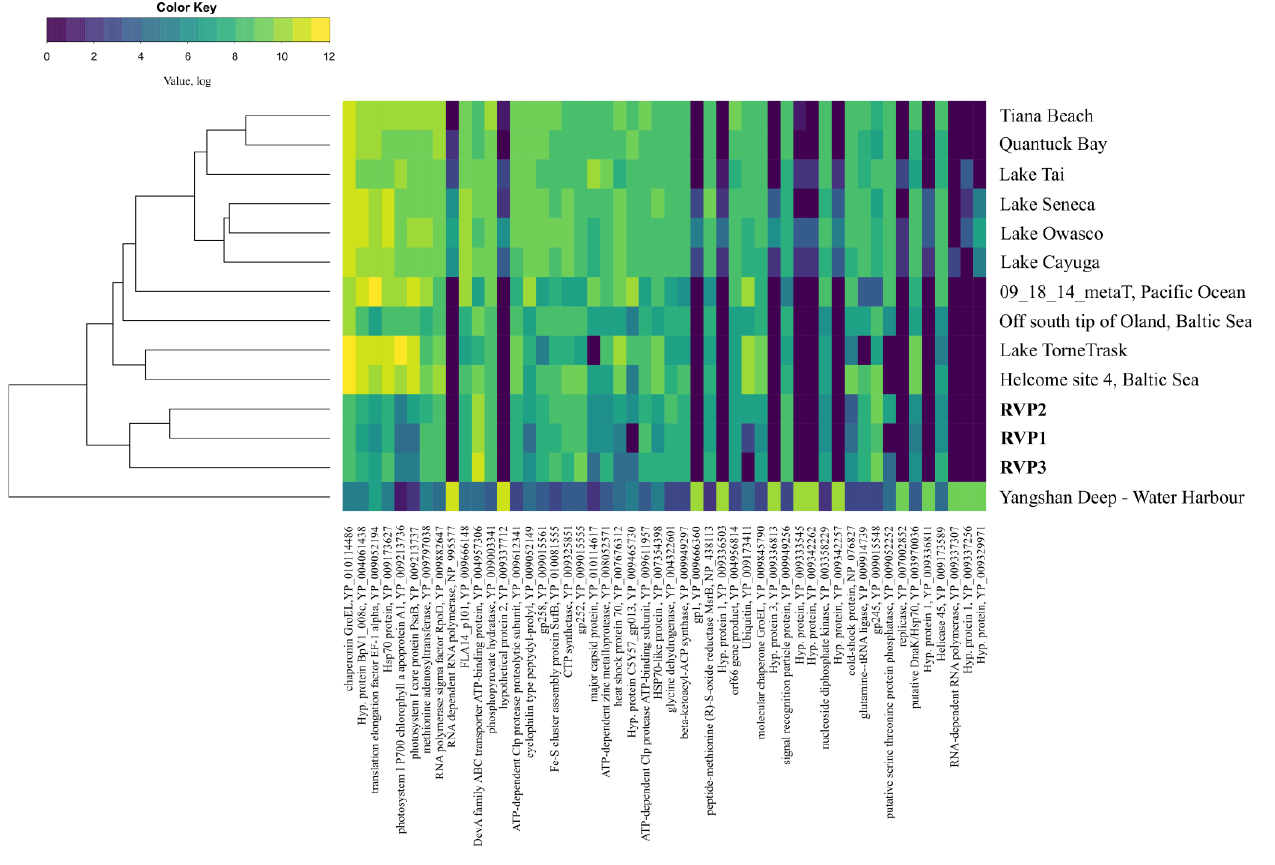
Figure 6. UPGMA dendrogram with a heat map created based on the abundance of viral proteins (RefSeq database); taxa with similarity ≥35% were taken into the analysis.